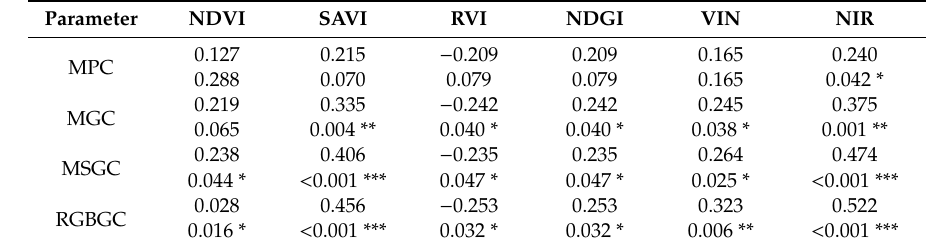
Table 3. The Pearson’s correlations between plot level mean vegetation indices extracted from multispectral images and ground-based